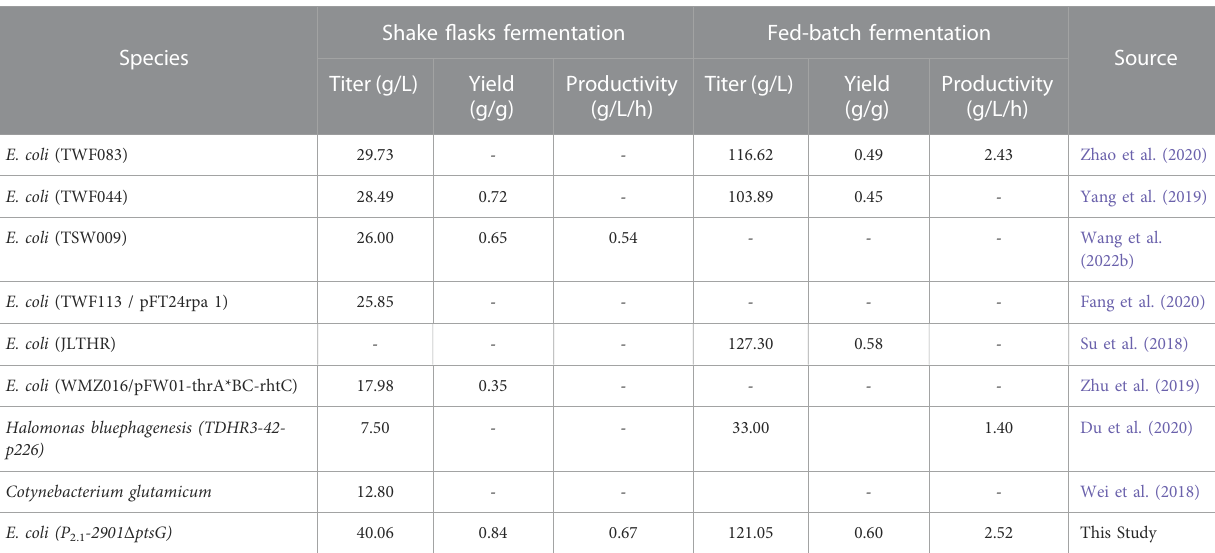
TABLE 1 L-threonine production using different